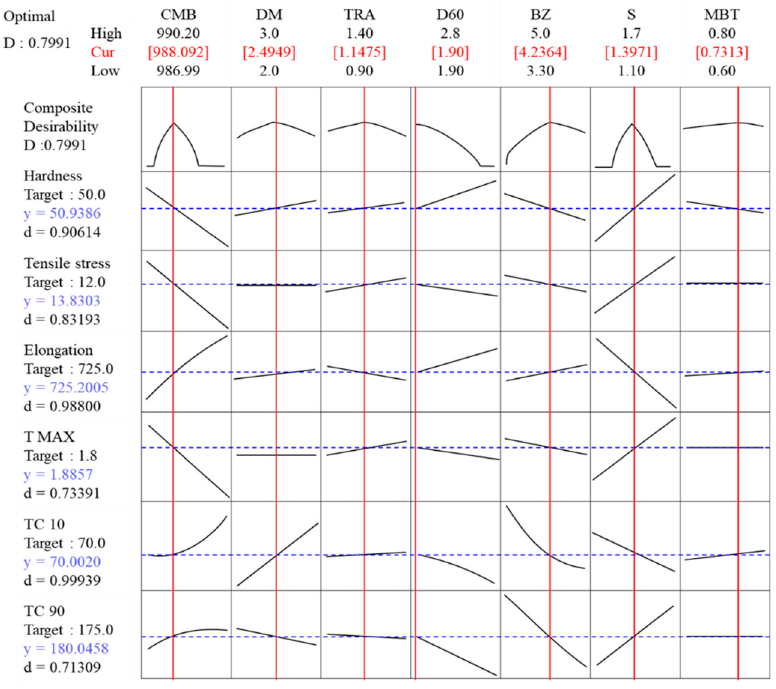
Figure 3. Optimization plot representing the mixing ratio of each component.